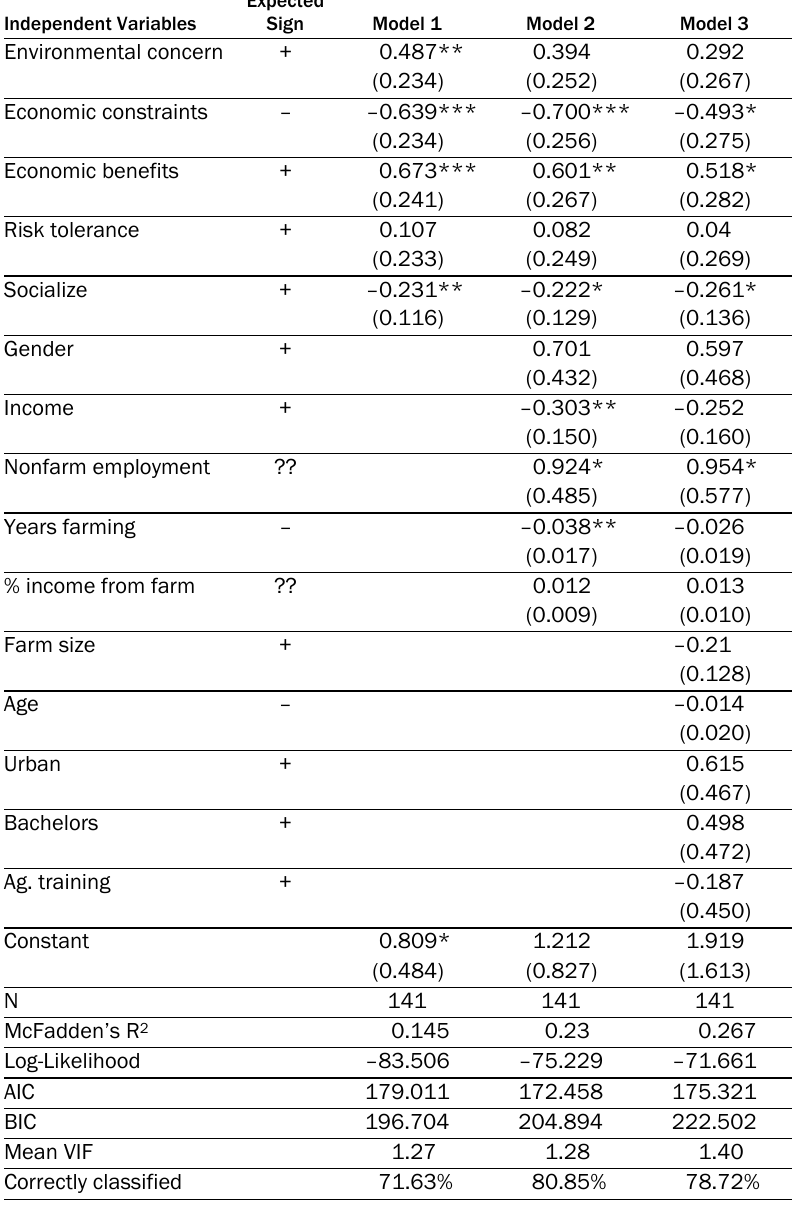
Table 3. Logistic Regression Results for the Likelihood of Adoption of Organic Farming Practices Independent